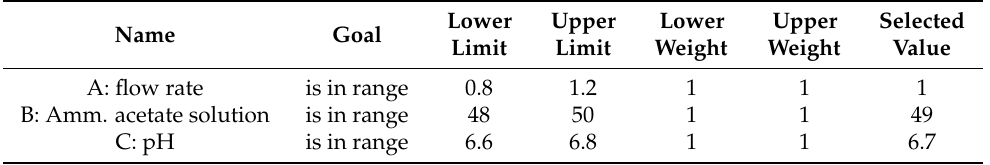
Table 5. Chromatographic